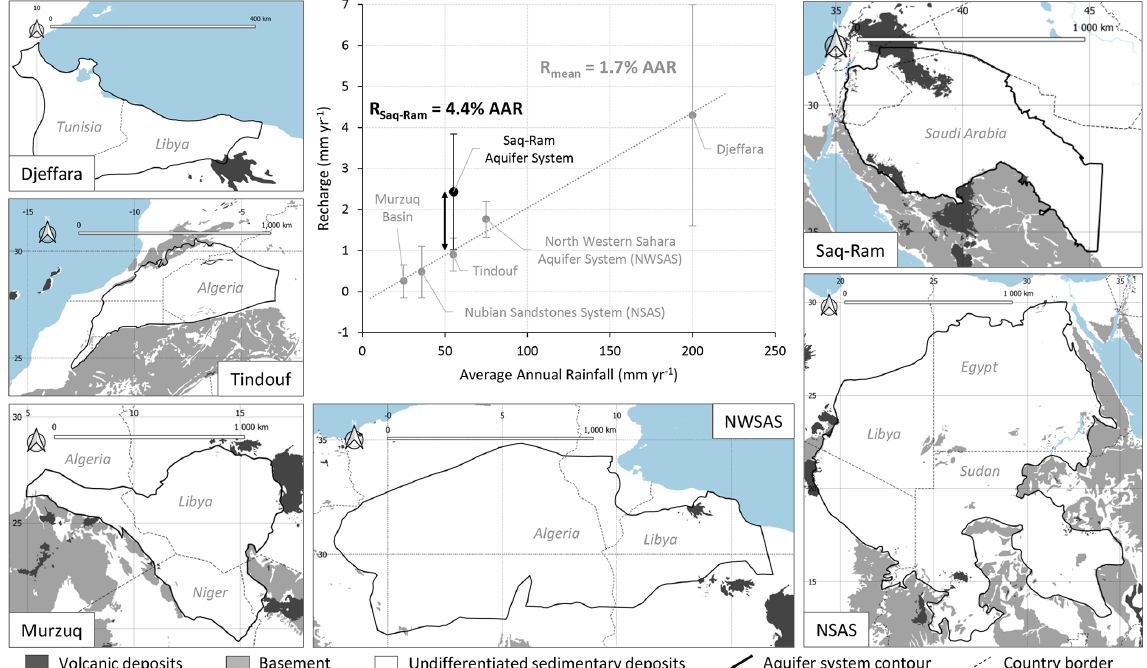
Figure 5. Recharge ( R ) versus annual average rainfall (AAR) for the Saq–Ram Aquifer System, compared to other Sahara aquifer systems assessed with a similar approach, and their associated simplified geological maps (Pollastro et al., 1999; Persits et al., 1997).